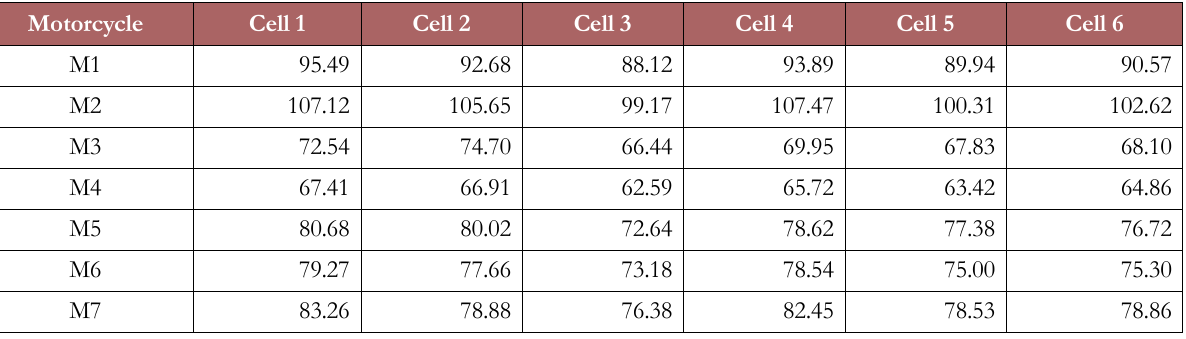
for the front of motorcycles [min] S